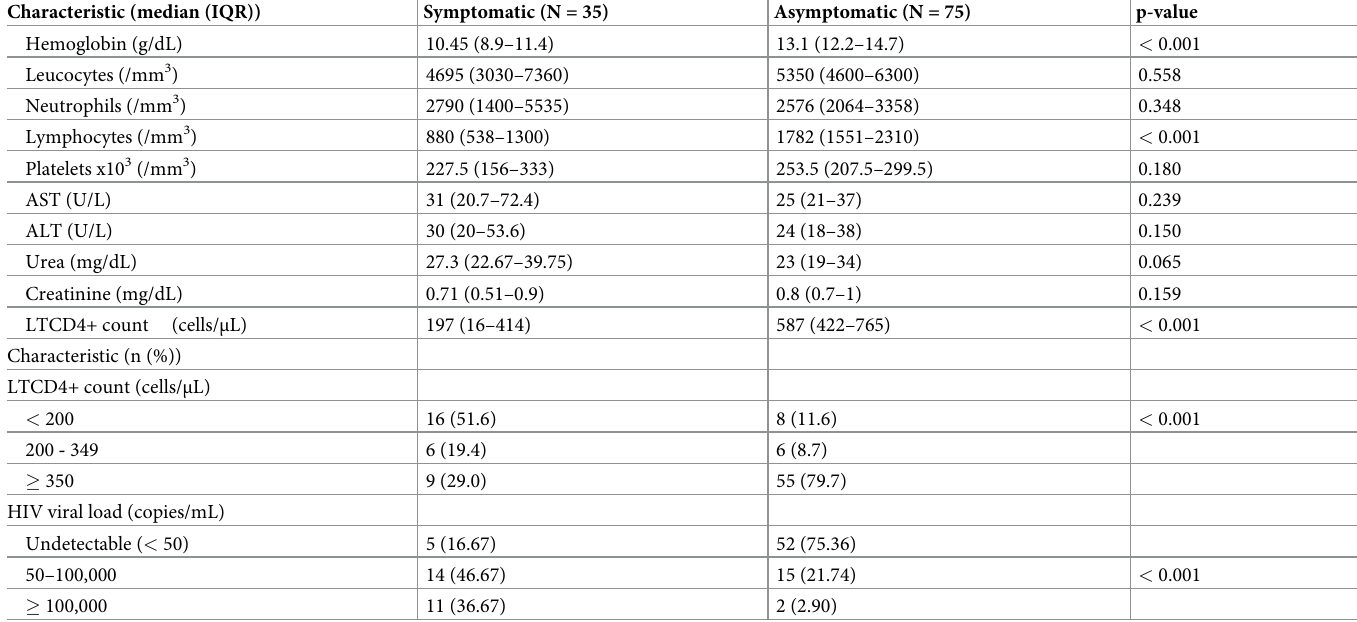
Table 2. Comparison of laboratory characteristics between symptomatic and asymptomatic VL-HIV coinfected individuals (univariate analysis) from Pernambuco, Brazil. Characteristic (median